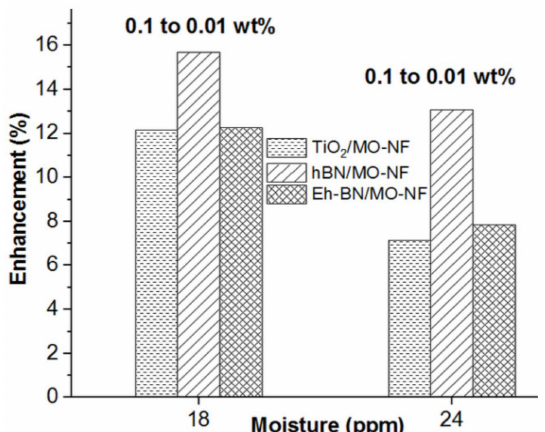
Figure 4. Enhancement of ACBDV of NFs between 0.01 and 0.1 wt.% of NP concentration for a moisture level of 18 and 24 ppm.